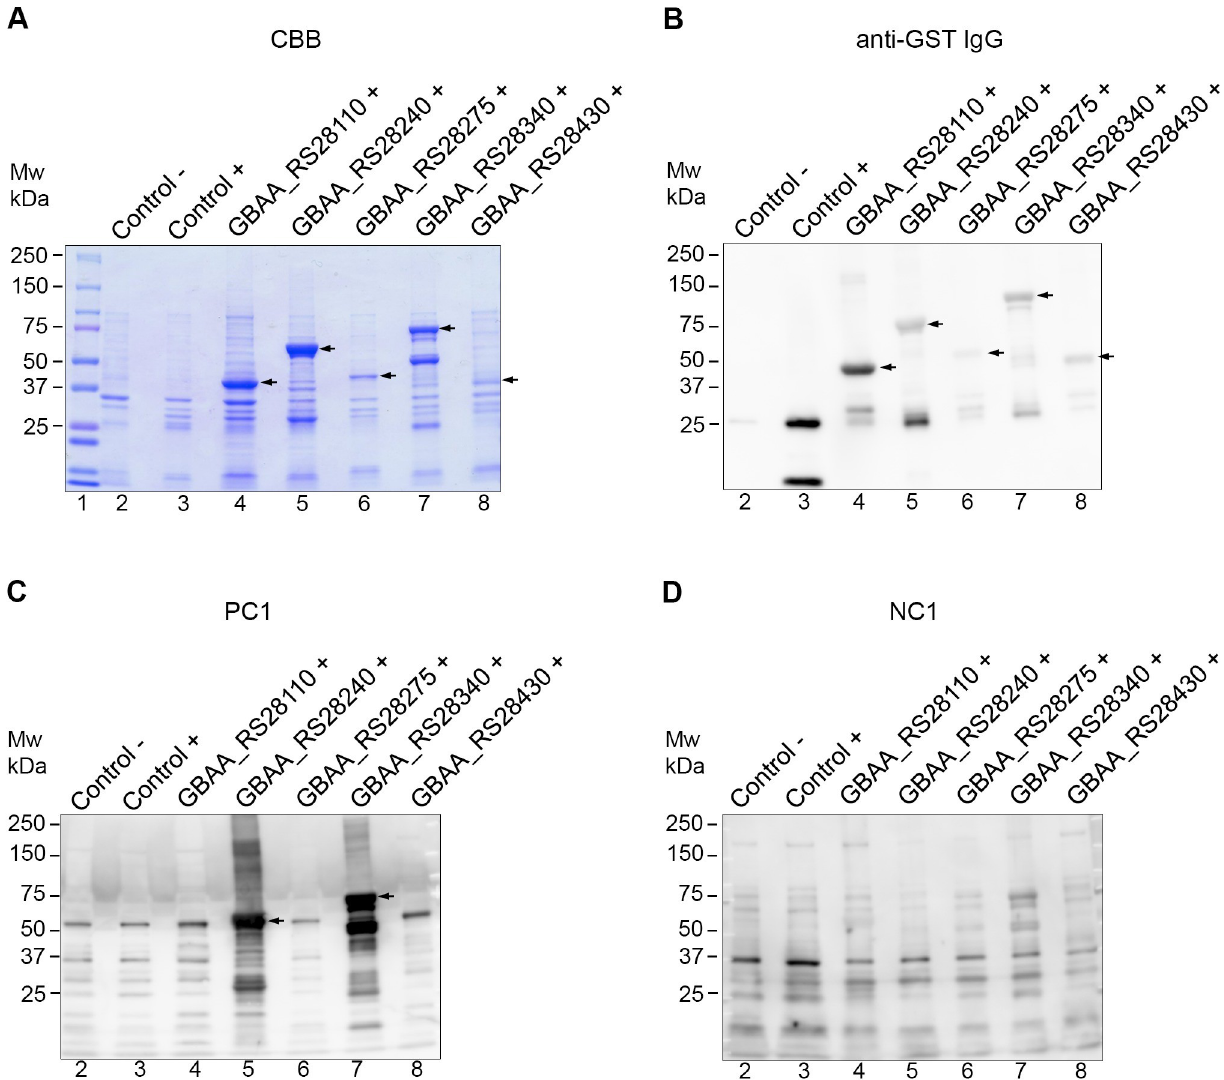
Fig 1. Expression and immunoreactivity of candidate proteins. (A) Coomassie brilliant blue (CBB) staining and (B–D) Western blotting of the proteins in cell pellet fractions of the control and candidate protein-expressing Escherichia coli strains grown in terrific broth. In Western blotting, the proteins in the cell pellets were probed with different antibodies: (B) anti-glutathione S-transferase (GST) immunoglobulin G; (C) horse hyperimmunized anti- Bacillus anthracis serum (PC1); (D) naive horse serum (NC1). Lane 1, Mw, molecular weight marker (in kDa); lane 2, control strain which is E . coli BL21 harboring empty pGEX-6P-2 without IPTG induction; lane 3, control strain which is E . coli BL21 harboring empty pGEX-6P-2 with 0.2 mM IPTG induction; lane 4, E . coli BTZ001 expressing recombinant hypothetical protein (GST-GBAA_RS28110: 44 kDa); lane 5, E . coli BTZ002 expressing recombinant capsule biosynthesis protein CapA (GST-GBAA_RS28240: 72 kDa); lane 6, E . coli BTZ003 expressing recombinant signal peptidase (GST-GBAA_RS28275: 47 kDa); lane 7, E . coli BTZ004 expressing recombinant peptide ABC substrate-binding protein (GST-GBAA_RS28340: 84 kDa); lane 8, E . coli BTZ005 expressing recombinant metal-dependent hydrolase (GST-GBAA_RS28430: 46 kDa). The arrows indicate target proteins in the expected